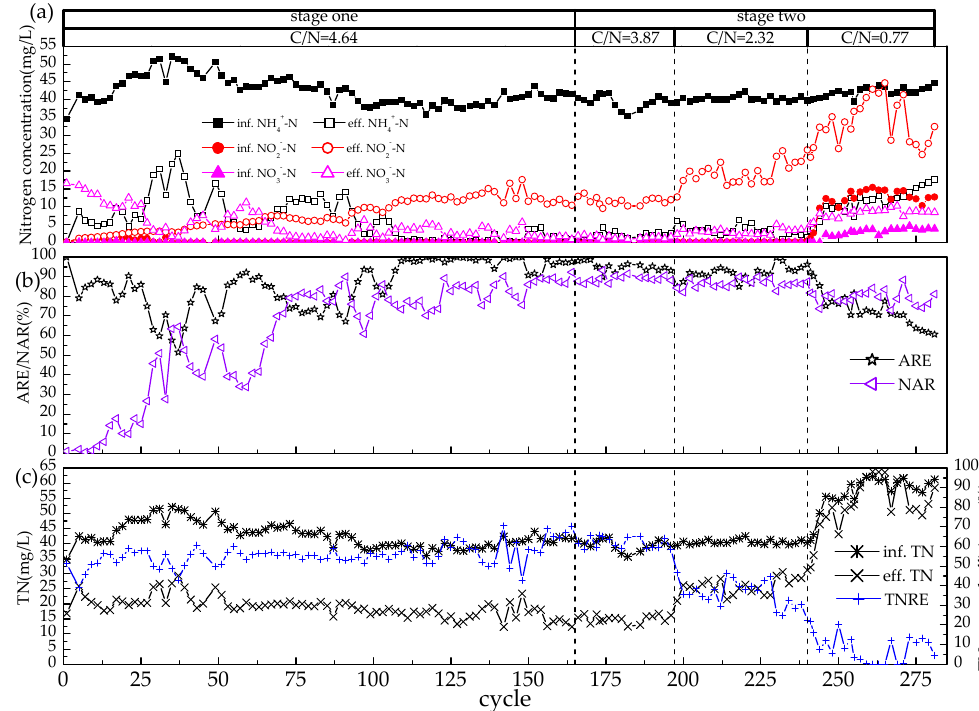
Figure 2. The reactor performance during the whole experiment: ( a ) The influent and effluent concentrations variation in NH 4+ -N, NO 2 − -N, and NO 3 − -N; ( b ) ammonia nitrogen removal efficiency (ARE) and nitrite accumulation rate (NAR); ( c ) the influent and effluent concentrations variation in total nitrogen (TN) and total nitrogen removal efficiency (TNRE). Table 1. The maximum activities of ammonia oxidation bacteria (AOB) and nitrite oxidation bacteria (NOB) at different C/N ratios.